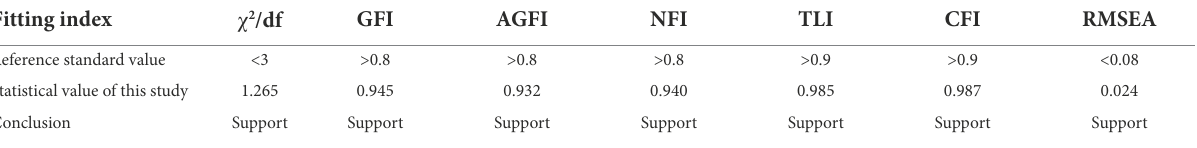
TABLE 4 The structural